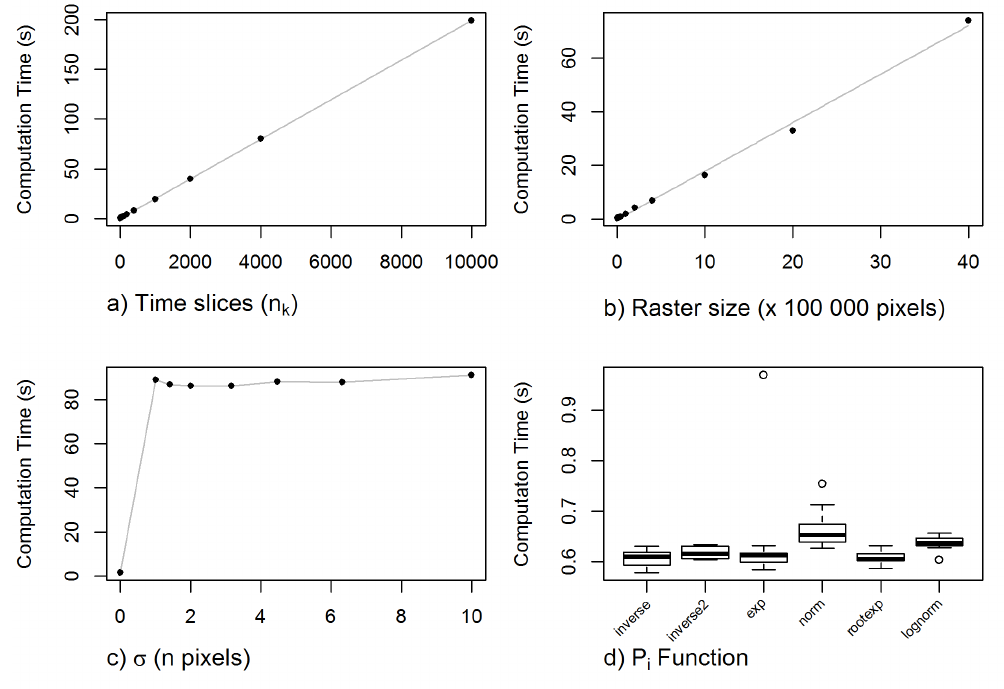
Figure 8: Computational speed of the field-based time geography algorithm (as currently developed) when varying a) the number of time slices parameter ( n k ), b) the raster